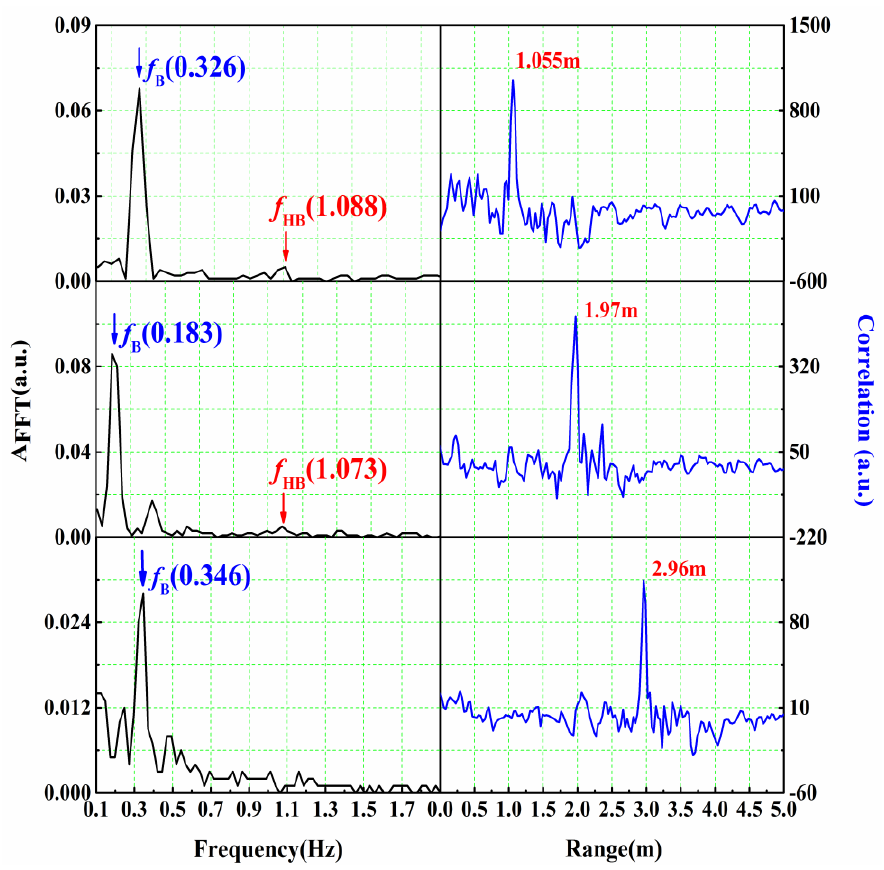
Figure 6. Experimental results with the cinder block wall for a human located at 1, 2, 3 m.